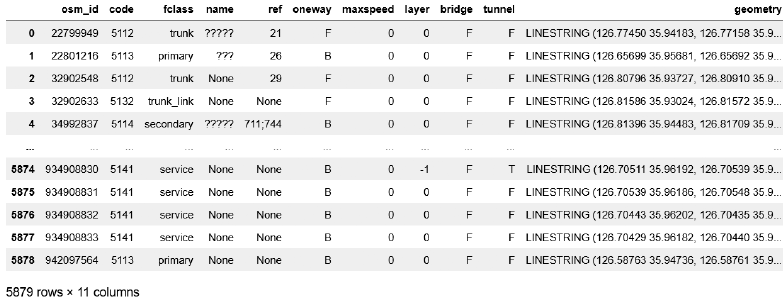
Figure 6. A capture of spatial road